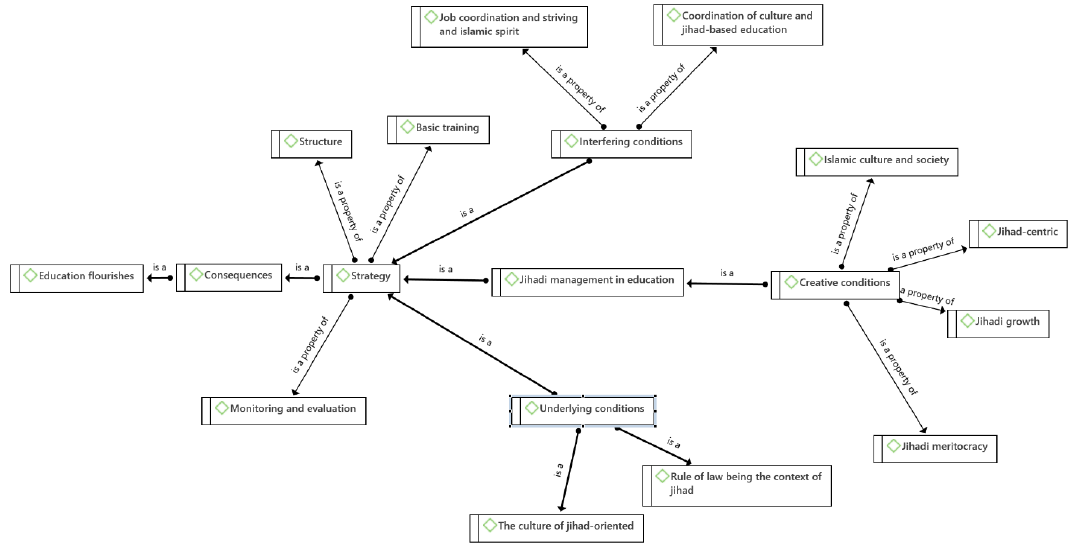
Figure 2: Convergence model of schools in the digital age based on the components of jihadi